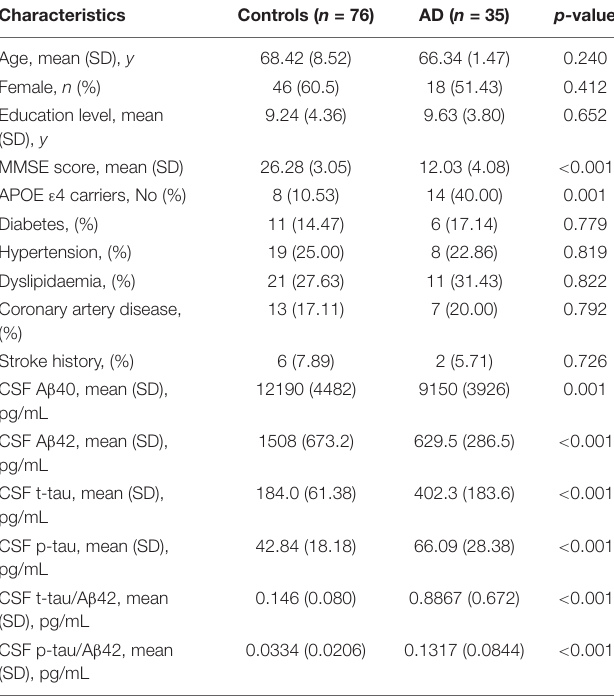
TABLE 2 | Characteristics of the participants with CSF